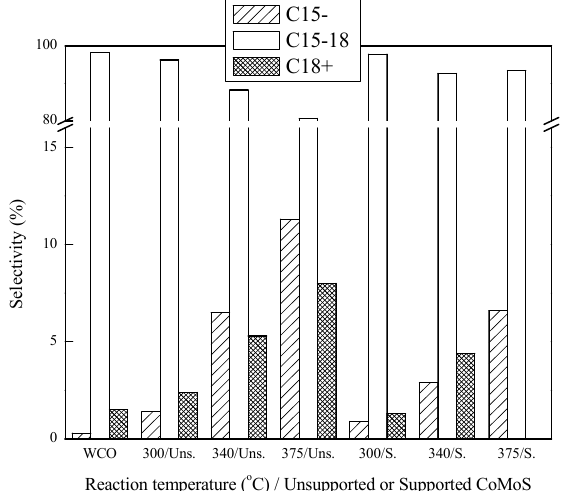
Figure 6. Hydrocracking and polymerization reactions during WCO hydrotreating